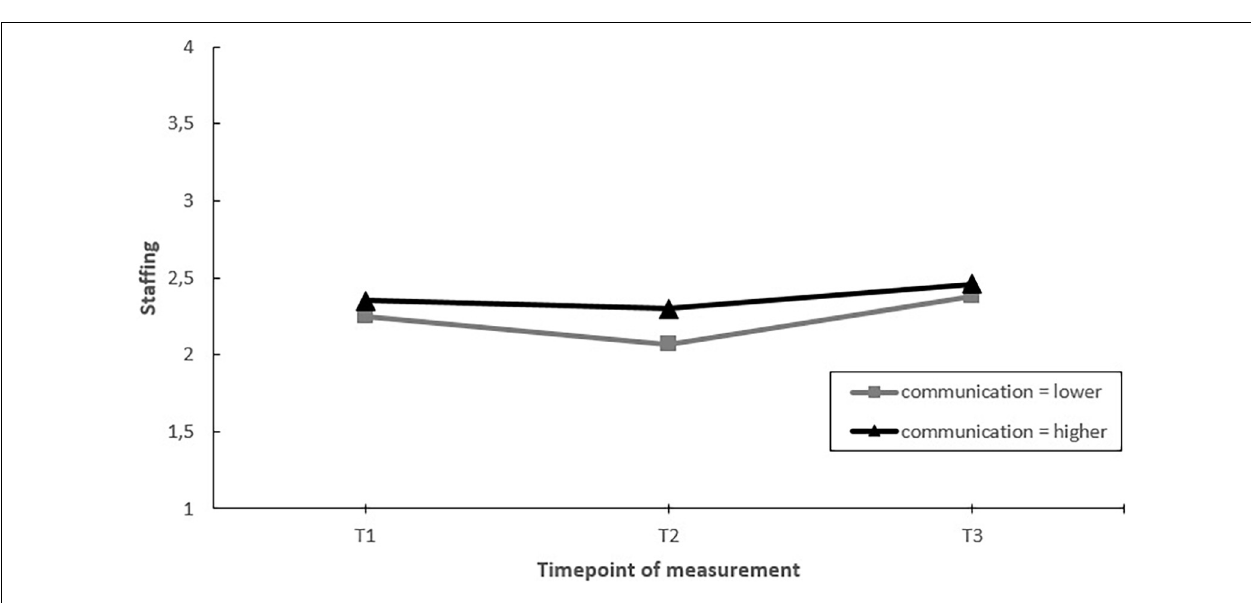
FIGURE 9 | Moderation effect of emergency departments with higher levels of communication versus emergency departments with lower levels of communication during the intervention project on changes in staffing over time. T1 = 2017, T2 = 2018, T3 =